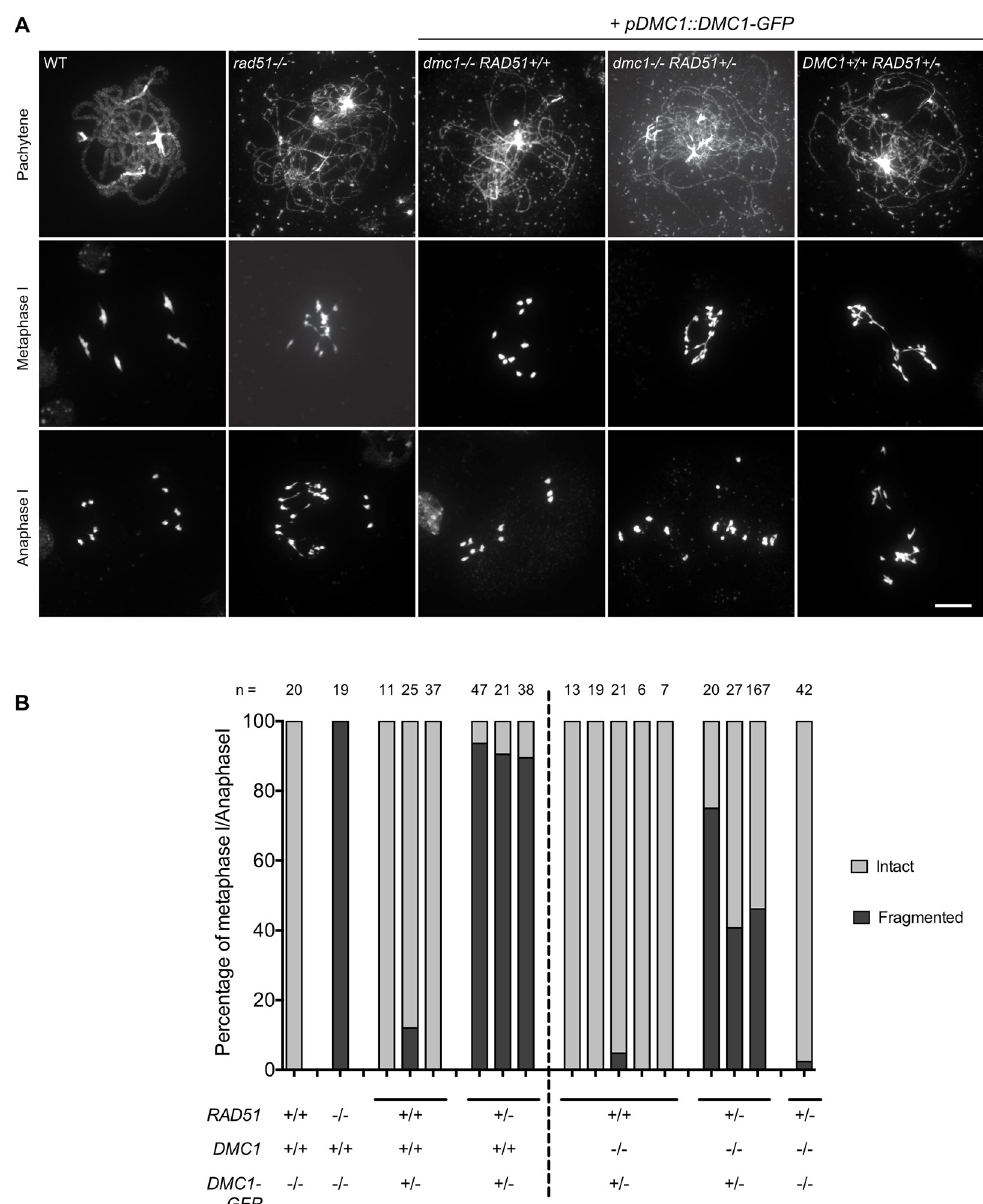
Fig 8. Expression of DMC1-GFP fusion protein inhibits RAD51-mediated repair of meiotic DBS. (A) DAPI staining of chromosomes during meiosis. Wild-type cells show pairing and synapsis of homologous chromosomes in pachytene, five bivalents at metaphase I and two groups of five chromosomes at anaphase I. rad51 mutants exhibit defective synapsis and extensive chromosome fragmentation. Meiotic spreads in dmc1-/- RAD51+/+ plants expressing DMC1-GFP revealed a dmc1-like phenotype with defective synapsis but ten intact univalents at metaphase I, which randomly segregate at anaphase I. In contrast, extensive fragmentation is observed in both dmc1-/- RAD51+/- and DMC1+/+ RAD51+/- plants expressing DMC1-GFP . (Scale Bar: 10 μ m). (B) Quantification of chromosome fragmentation. The genotype of the plants is indicated below each bar and number of cells analyzed is listed above. phenotype point both to a particularity of the DMC1-GFP protein, but do not affect the con- clusion that DMC1-GFP impedes DMC1-mediated recombination and triggers downregula- tion of meiotic RAD51-mediated recombination.